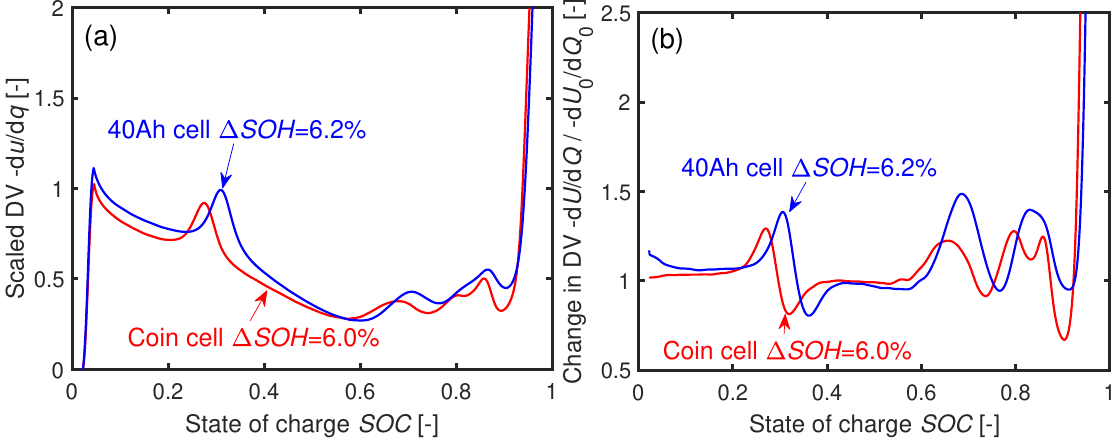
Figure 13. ( a ) Normed DVs of a 40Ah cell and a coin cell cycled at T = 35 ◦ C after similar loss of capacity. ( b ) Relative change to the DV of the respective cells in comparison to BOL d U 0 /d Q 0 . The coin cell was cycled 150 times and the 40Ah cell 1200 times to reach the respective ∆ SOH